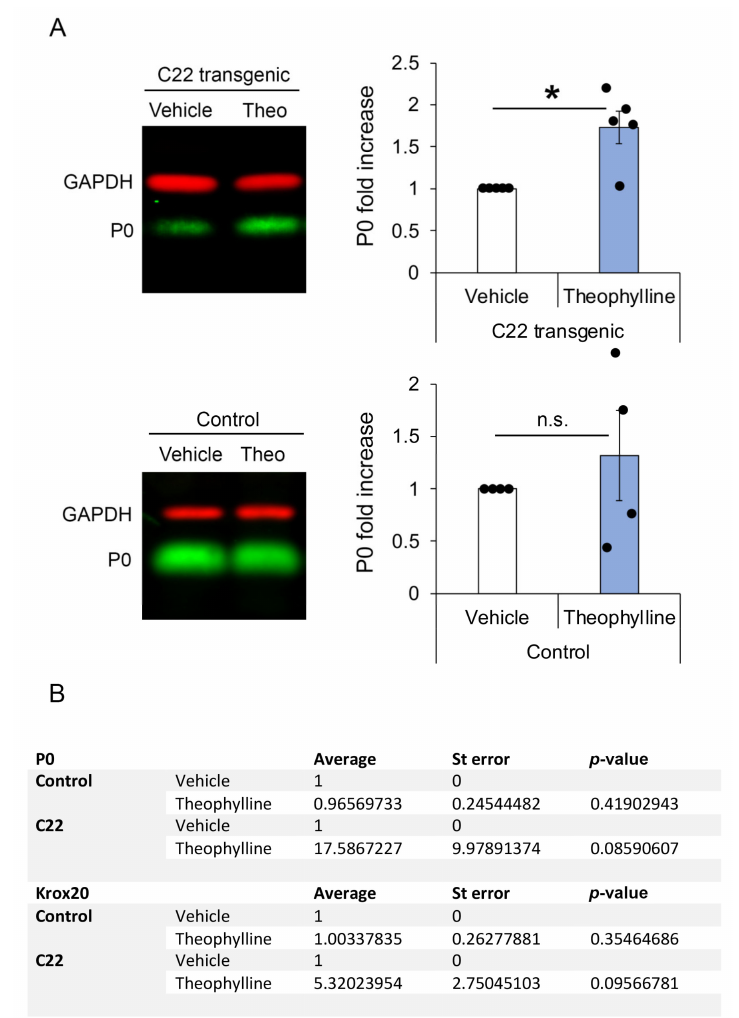
as shown in Figure 1A.